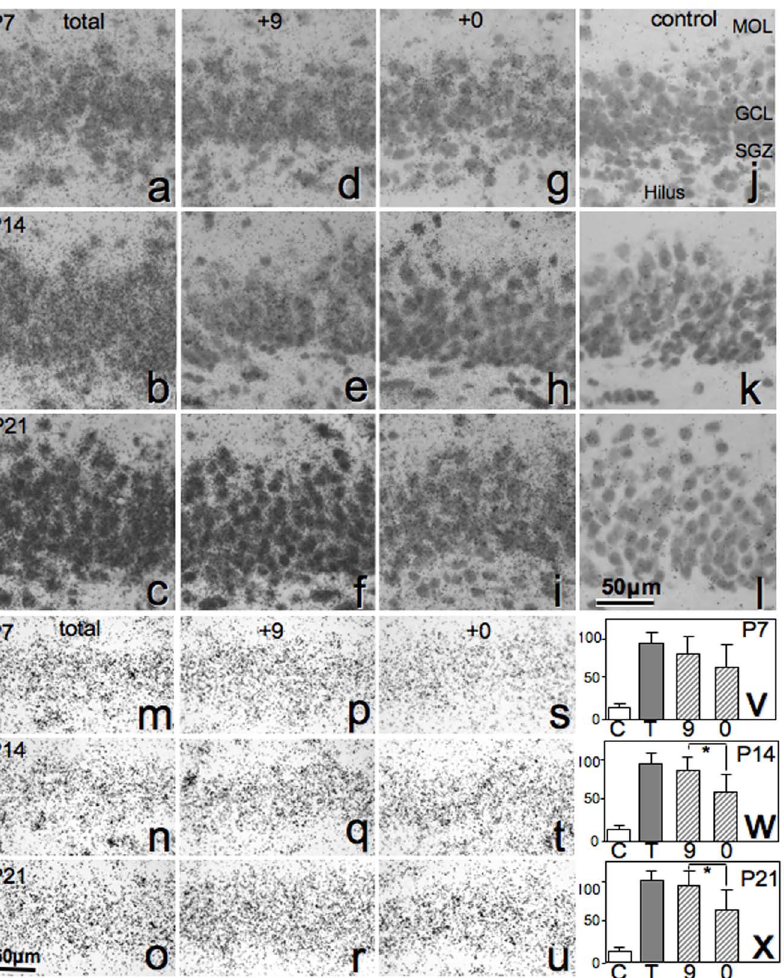
Figure 6. Developmental changes in Pro + 0 and Pro + 9 mRNA levels. Expression of total (Pro + 0 and Pro + 9) mRNA ( a–c , m–o, using probe PS- AS1), Pro + 0 mRNA ( d–f , p–r, using probe PS-AS4), Pro + 9 mRNA ( g–i, s–u, using probe PS-AS3) and negative control ( j–l, using probe S1) in the dentate gyrus at P7 ( a , d , g, j, m, p, s, v ), P14 ( b , e , h, k, n, q, t ) and P21 ( c , f , I, l, o, r, u, x ). Cells depicted in a–l were counterstained with hematoxylin and eosin (HE). At all stages, Pro + 9 mRNA staining was of greater intensity than Pro + 0 mRNA. In v–x , the columns indicate control (C), total (T), Pro + 9 mRNA (9) and Pro + 0 mRNA (0). * P , 0.05.